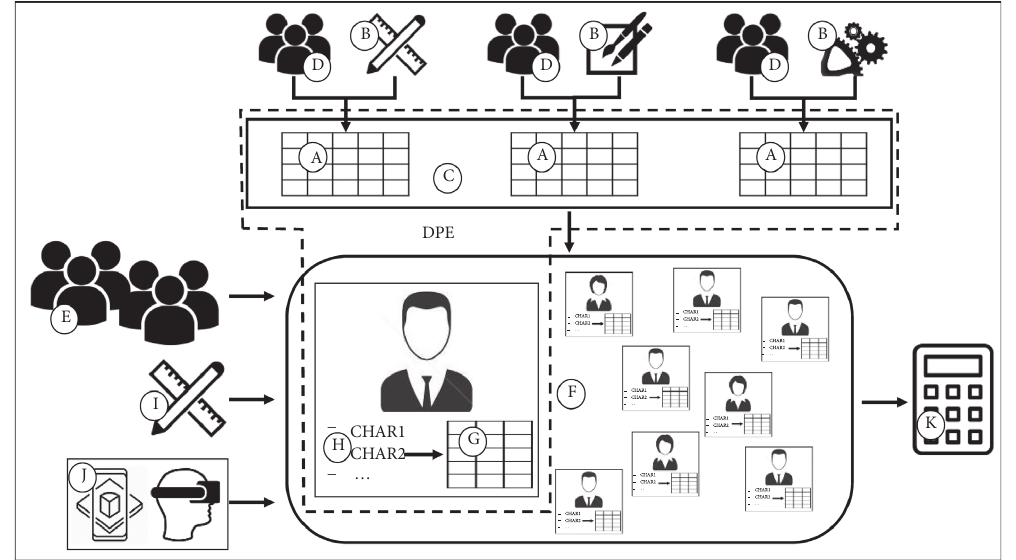
Figure 1: Role of the DPE in a team performance